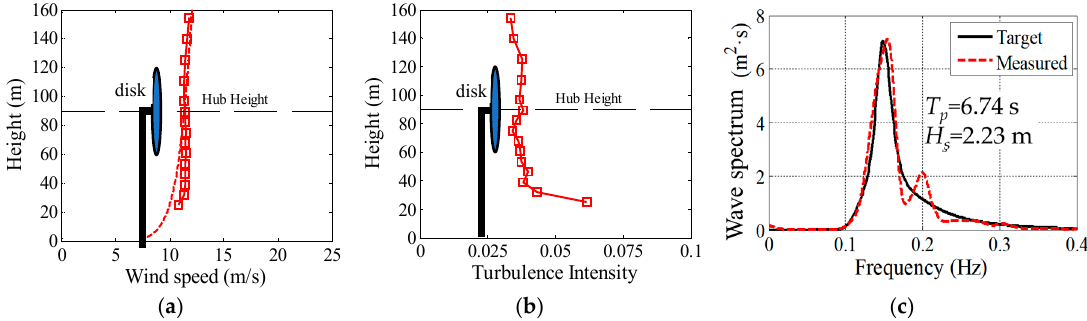
Figure 8. The measured wind and wave fields: ( a ) Average wind speed profile; ( b ) Turbulence intensity profile; ( c ) Stochastic wave spectrum.